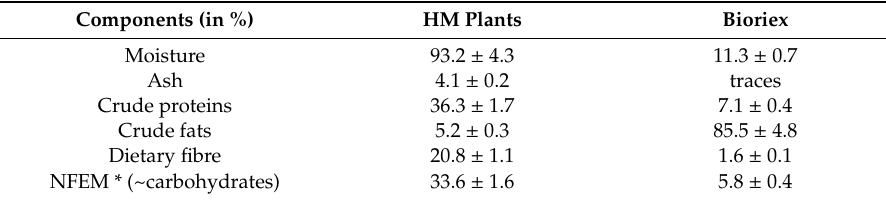
Table 2. Proximate analysis of herbal mix (HM) and final product